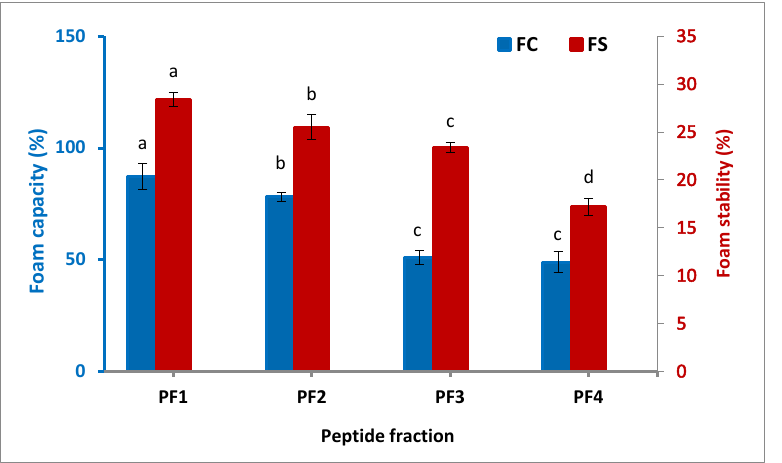
Figure 3. Foam capacity and stability of the isolated peptide fractions. Results are illustrated as means ± SD and values within each variable with the different letters are significantly different ( p < 0.05)